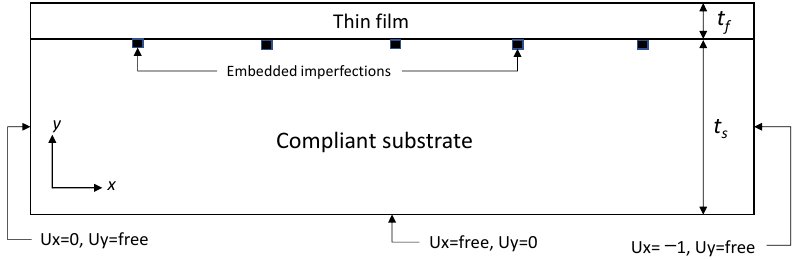
Figure 1. The 2D wrinkling model and boundary conditions.